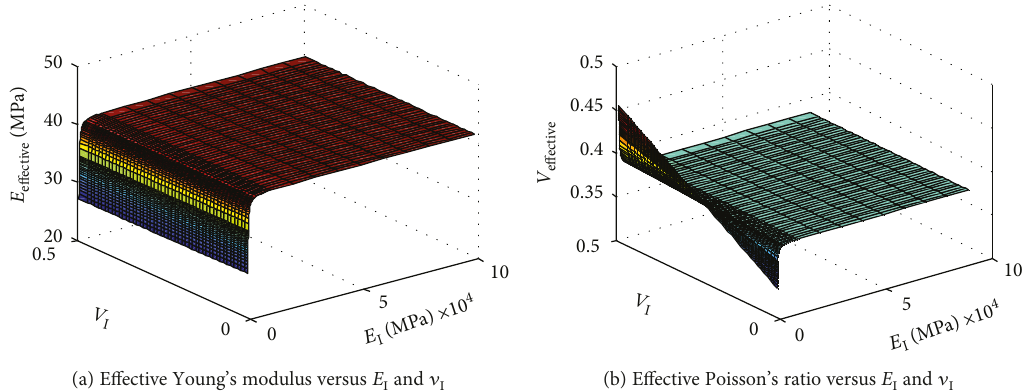
Figure 10: E ff ective properties of solid propellants versus E